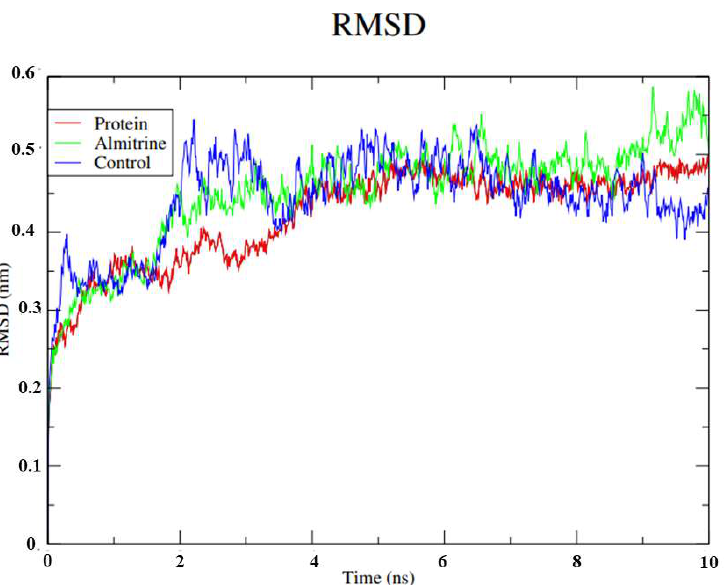
Figure 4. RMSD values for the Cα atoms of the transporting ATPase alpha 1 of H. sapiens complexed with almitrine and the control (thapsigargine). Legend: Green: ATPase of H. sapiens complexed with almitrine; Blue: ATPase of H. sapiens complexed with thapsigargine; and Red: H. sapiens transporting ATPase homologous protein.